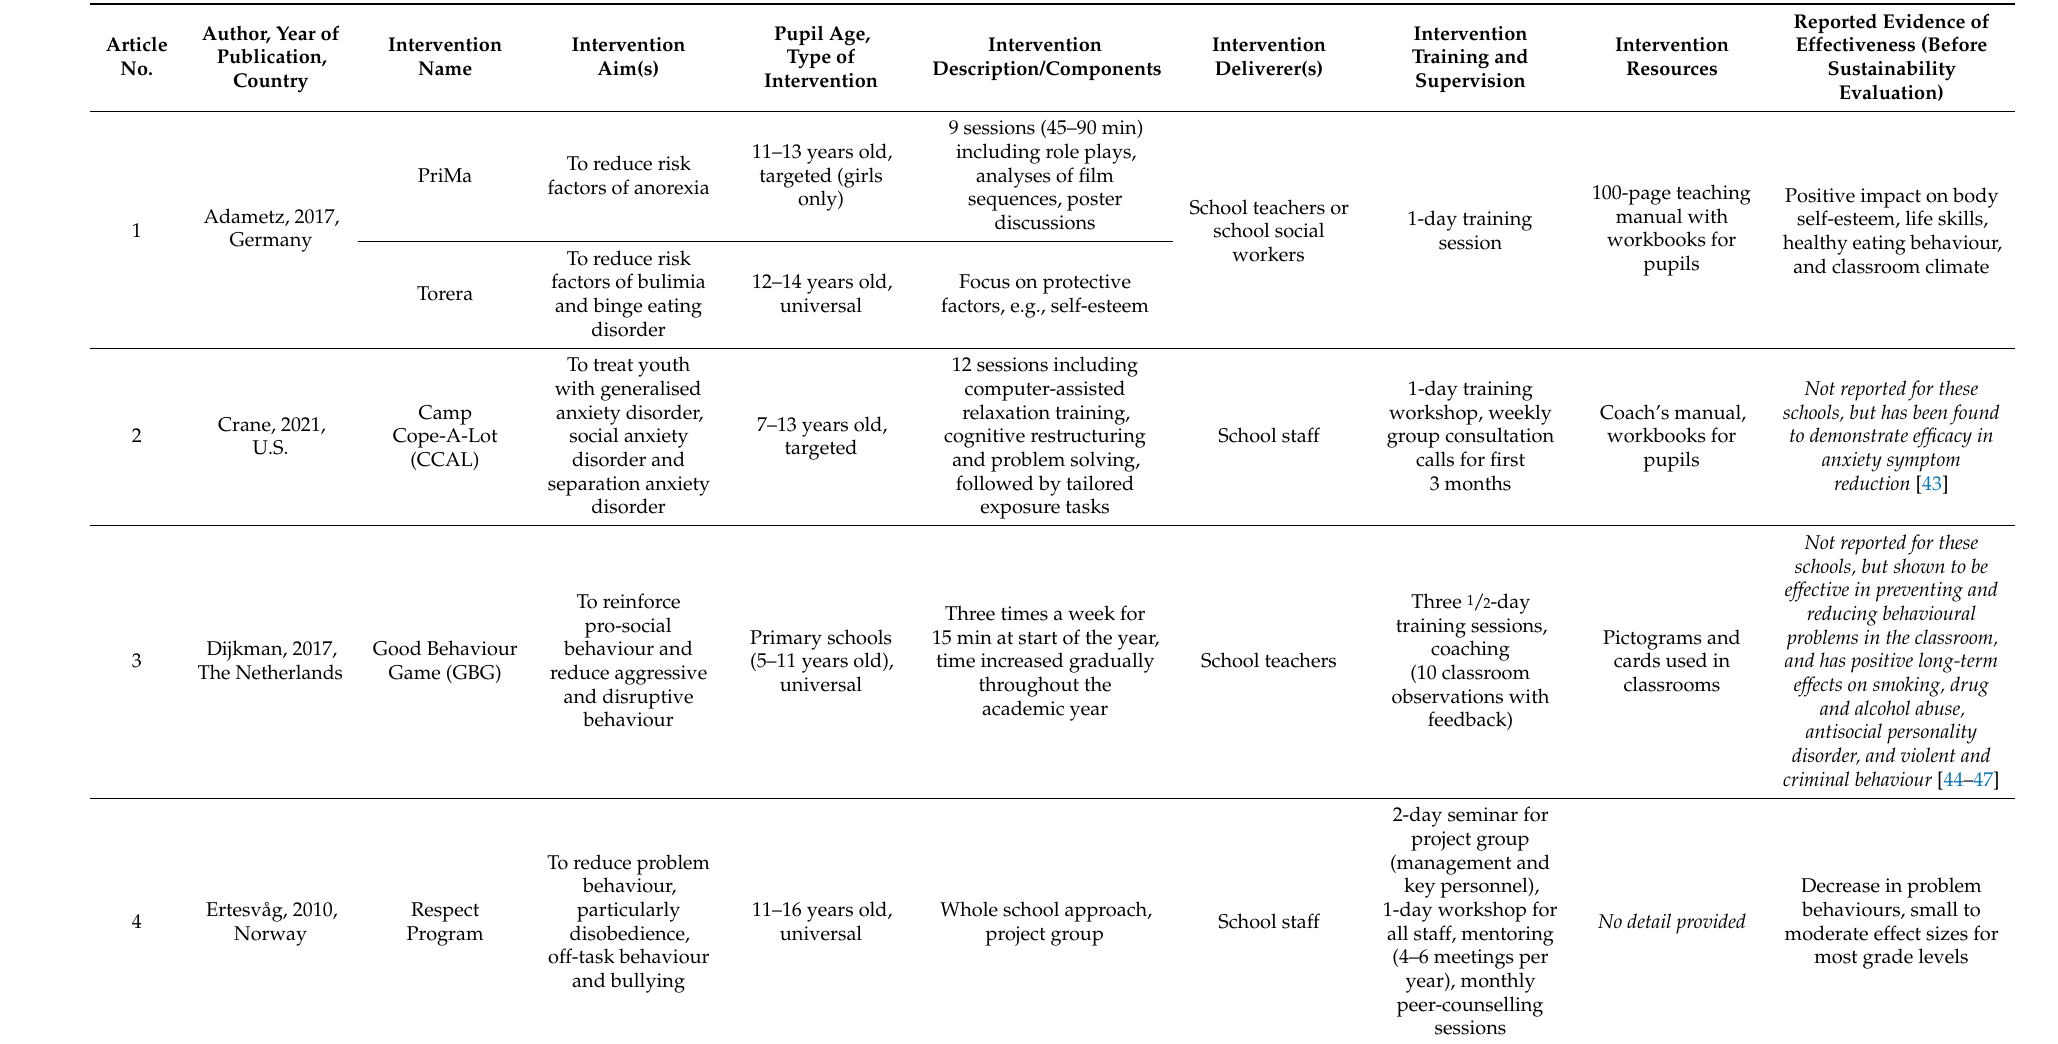
Table 1. Interventions included in the